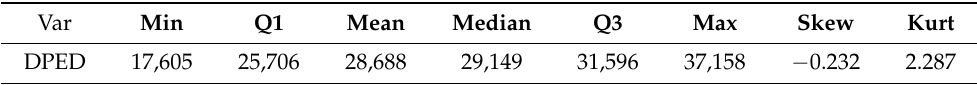
Table 3. Descriptive statistics of